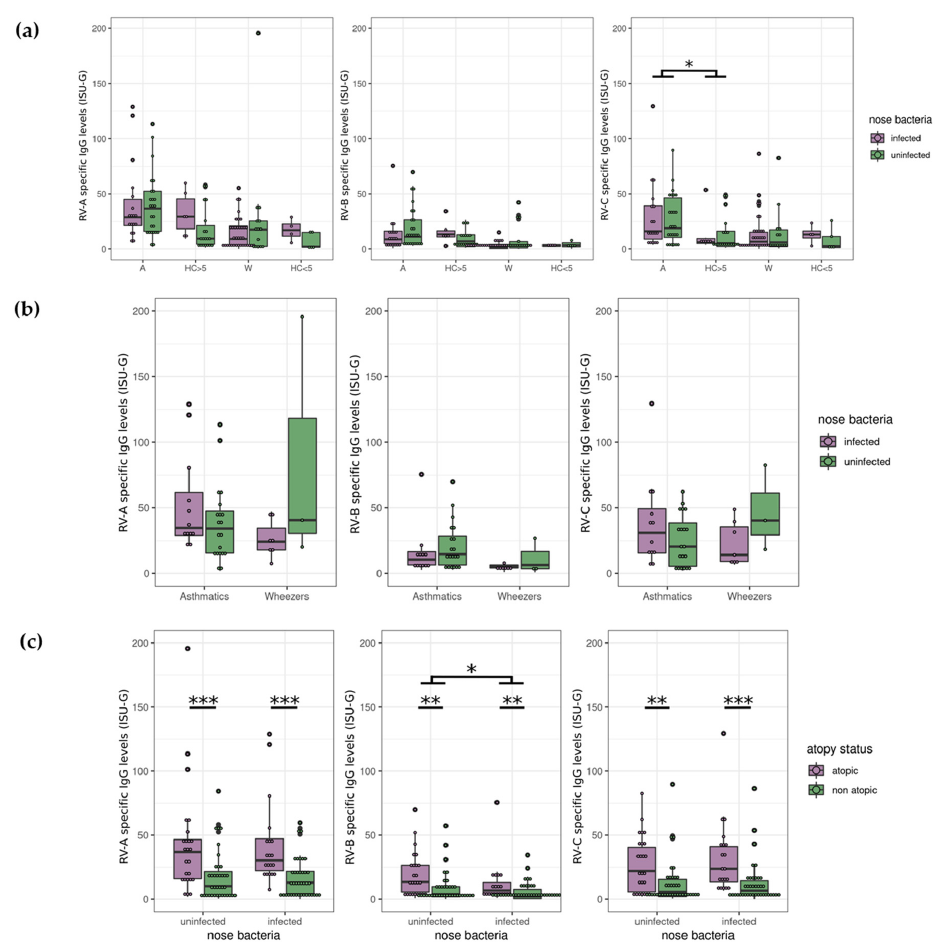
Figure 4. Nose bacteria infection (detection; positive bacterial test result in the nasopharyngeal region) showed variable results within phenotypes. ( a ) For each species and each age group (older or younger than five years old), the influence on RV-specific IgG level of disease, nose bacteria ‘infection’ or interaction of both factors were tested using an ART model (non-parametric equivalent of a 2-way ANOVA test). The p -values were corrected using the FDR method. ( b ) Nose bacteria infection does not correlate with RV-specific IgG levels in atopic patients. For each species, the RV-specific IgG levels of nose bacteria infected atopic asthmatics were compared with that of bacteria-unin- fected atopic asthmatics using Mann–Whitney U tests. The same comparisons were conducted in atopic wheezers. All p -values were corrected using the FDR method. No significant effect of nose bacteria infection on the RV-specific IgG levels of atopic patients was detected for any age group or RV species. ( c ) Participants with nose bacteria infection had a lower RV-specific IgG level of species B. For each RV species, the influence on virus IgG level of atopy status, nose bacteria ‘infection’, or interaction of both factors were tested using an ART model. The p -values were corrected using the FDR method. Atopy was significantly associated with higher virus-specific IgG level for all three species ( p = 0.0000059, p = 0.00076 and p = 0.000034 for A, B and C-species, respectively). Interaction of atopy and bacteria infection was not significantly correlated with virus-specific antibody levels. Post-hoc pairwise comparisons were conducted using Mann–Whitney U tests (*: 0.01 < p < 0.05; **: 0.001 < p < 0.01; *** p < 0.001; A: Asthmatics, HC > 5: Healthy controls five years old or older, W: Wheezers, HC < 5: Healthy controls younger than five years of age).